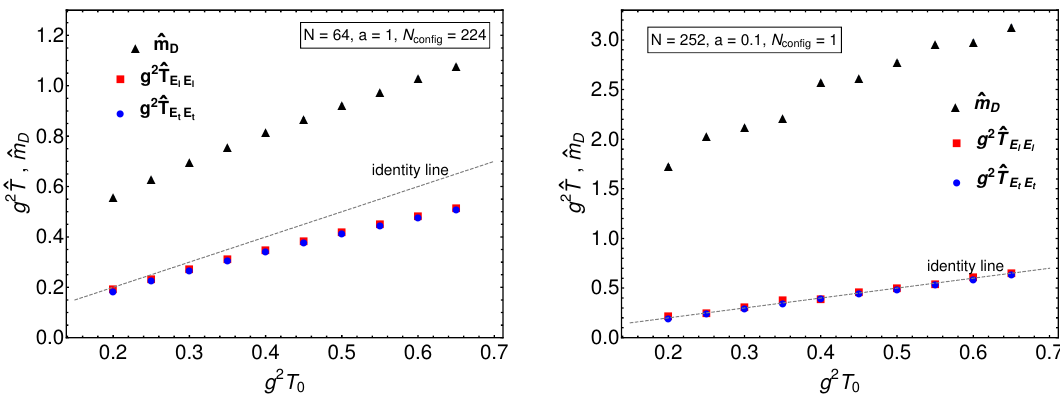
Figure 2 . Extracted values of g 2 ˆ T E and a = 0 . 1 (right). All parameters are shown in lattice